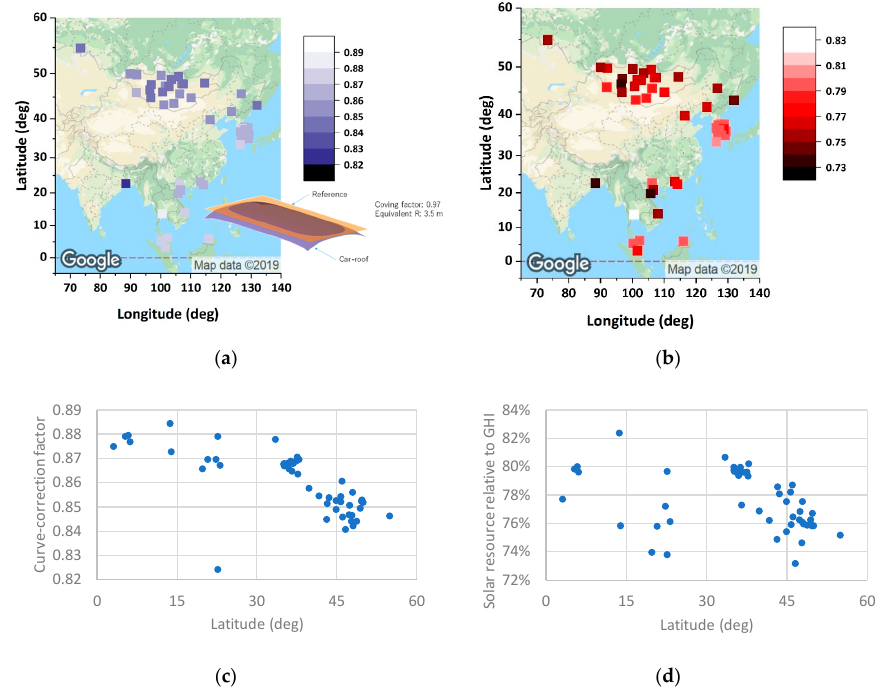
Figure 19. Map of the effective solar irradiance for the car roof: ( a ) curve-correction factor in a typical car roof; ( b ) effective solar resource to the car roof normalized to GHI, including the loss by the curved surface; ( c ) correlations between latitude (related to the sun height) and the curve correction factor; ( d ) correlations between latitude (related to sun height) and the effective solar resource to the car roof normalized to GHI, including the loss by the curved surface.